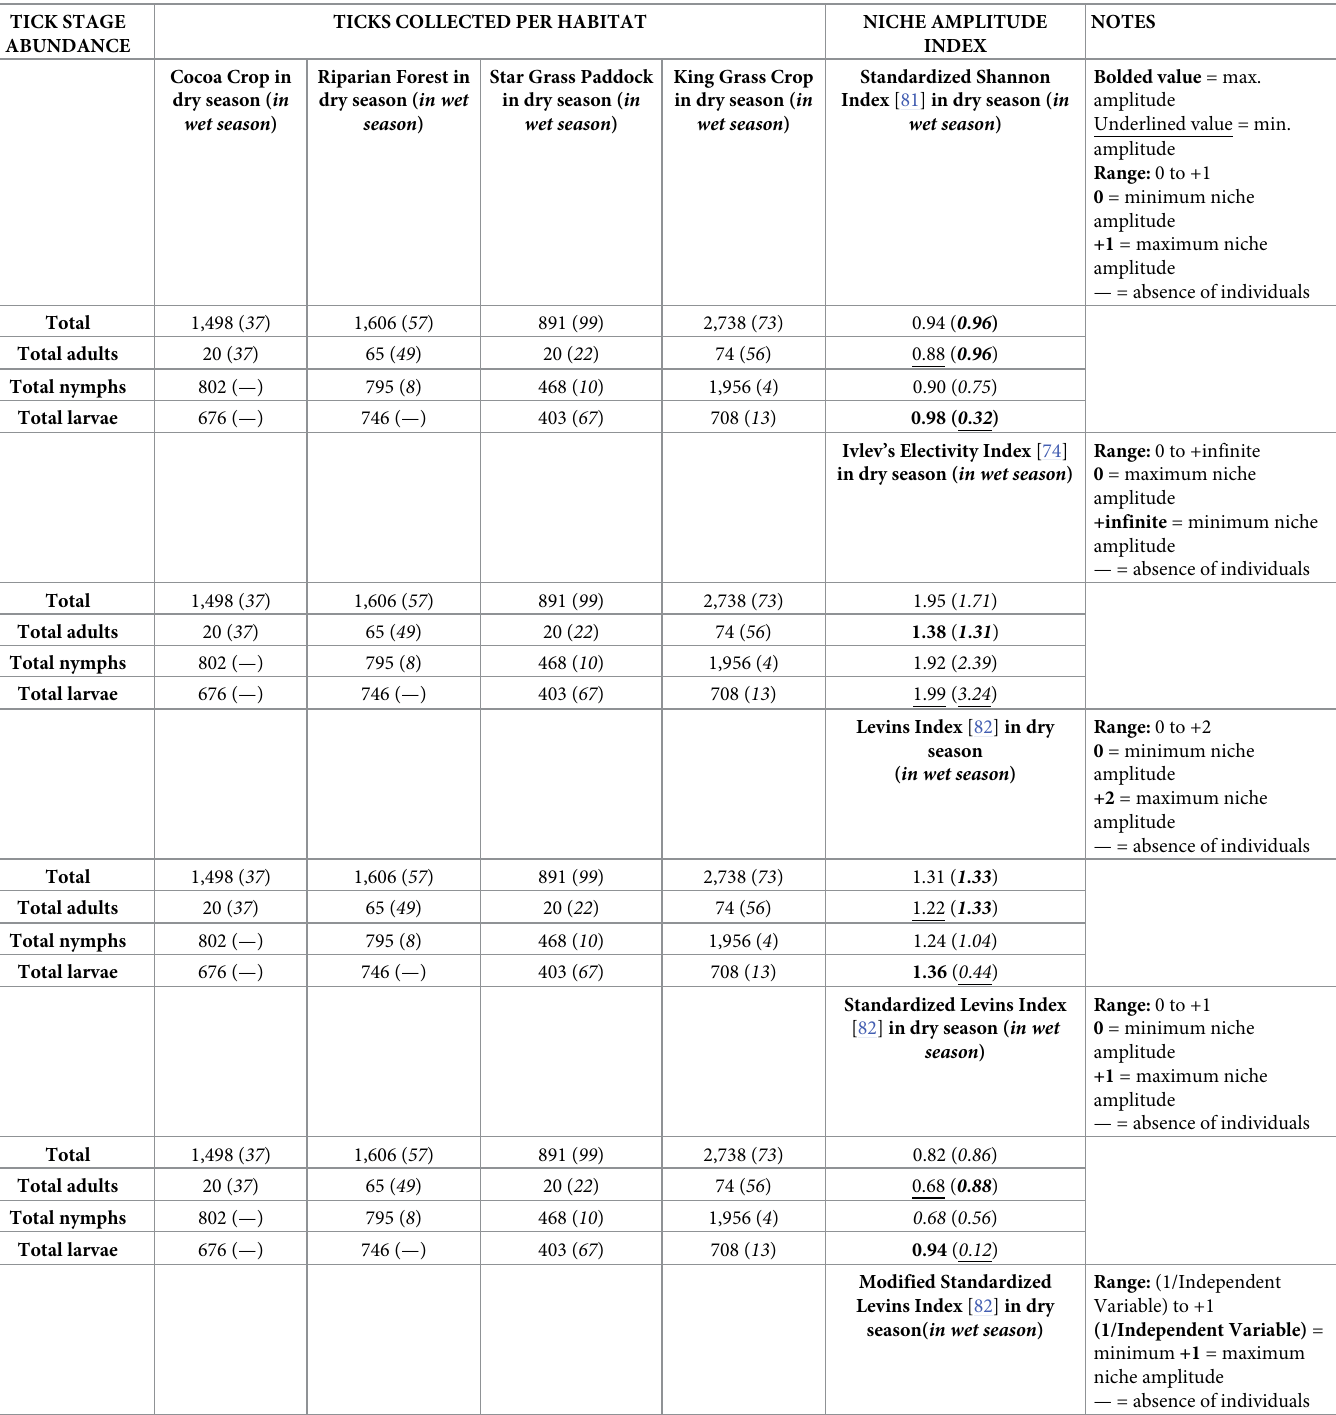
Table 5. Calculations of the best five niche amplitude indices for A . mixtum within its habitats in the Matepantano Farm by using HaviStat 2.4 1